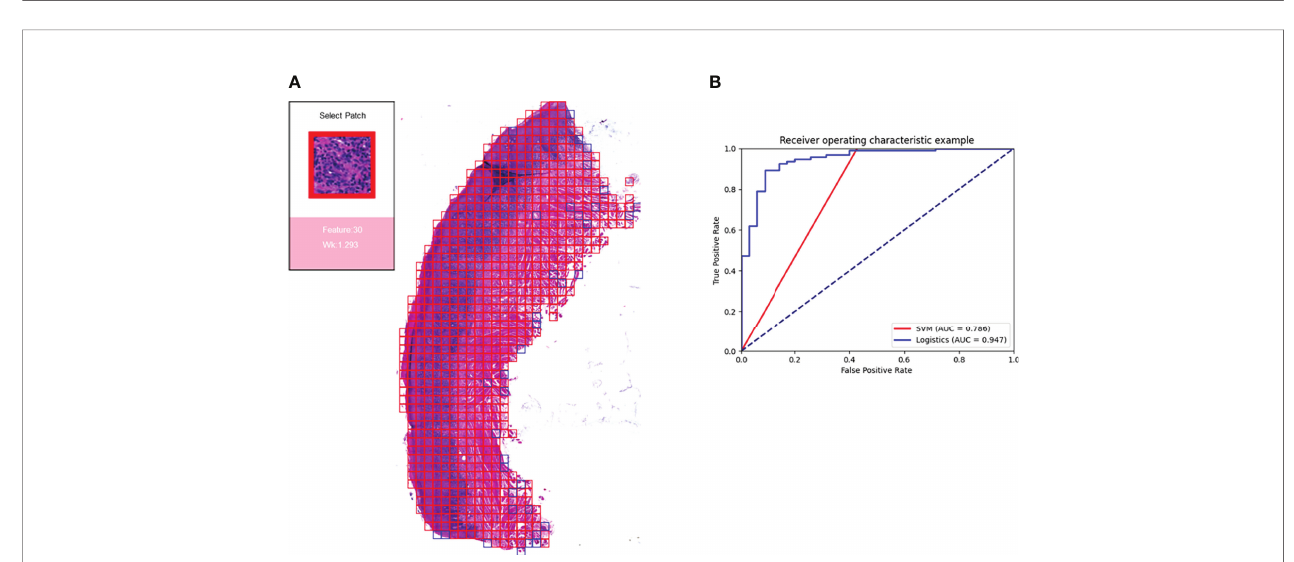
FIGURE 6 | Differences in the pathways corresponding to the high and low expression groups of each feature. Panels (A – F) showed the differences in expression in the high and low expression groups of each feature in Figure 5 for the pathways enriched in the high and low expression groups of that feature, respectively. The P- value for the differences in pathway enrichment in the high and low expression groups for each feature is less than